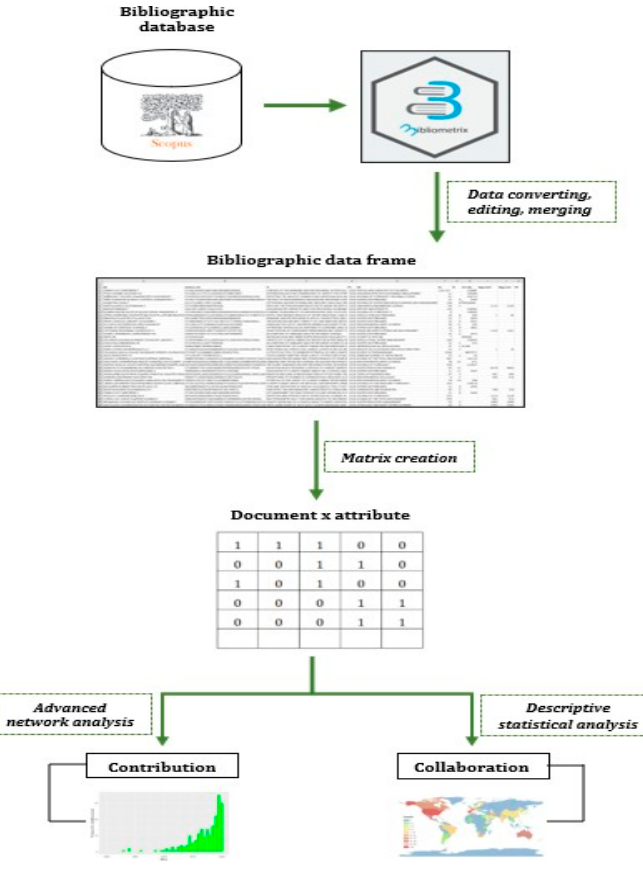
Figure 1. Workflow of bibliometrix analysis.